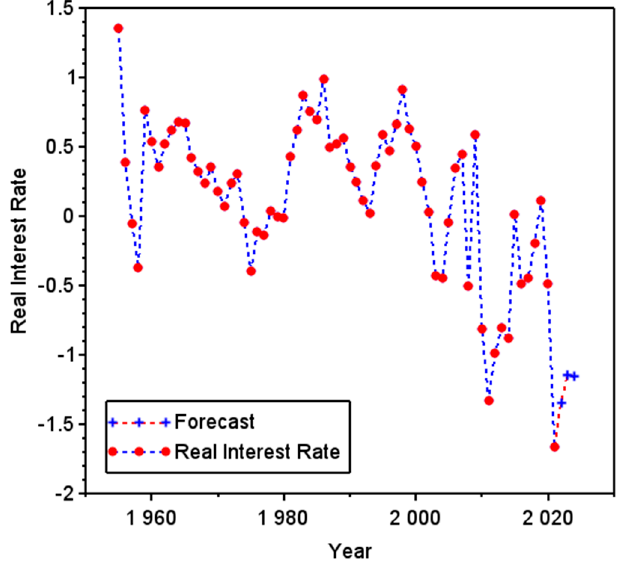
Figure 4. Real interest rates and forecasts.